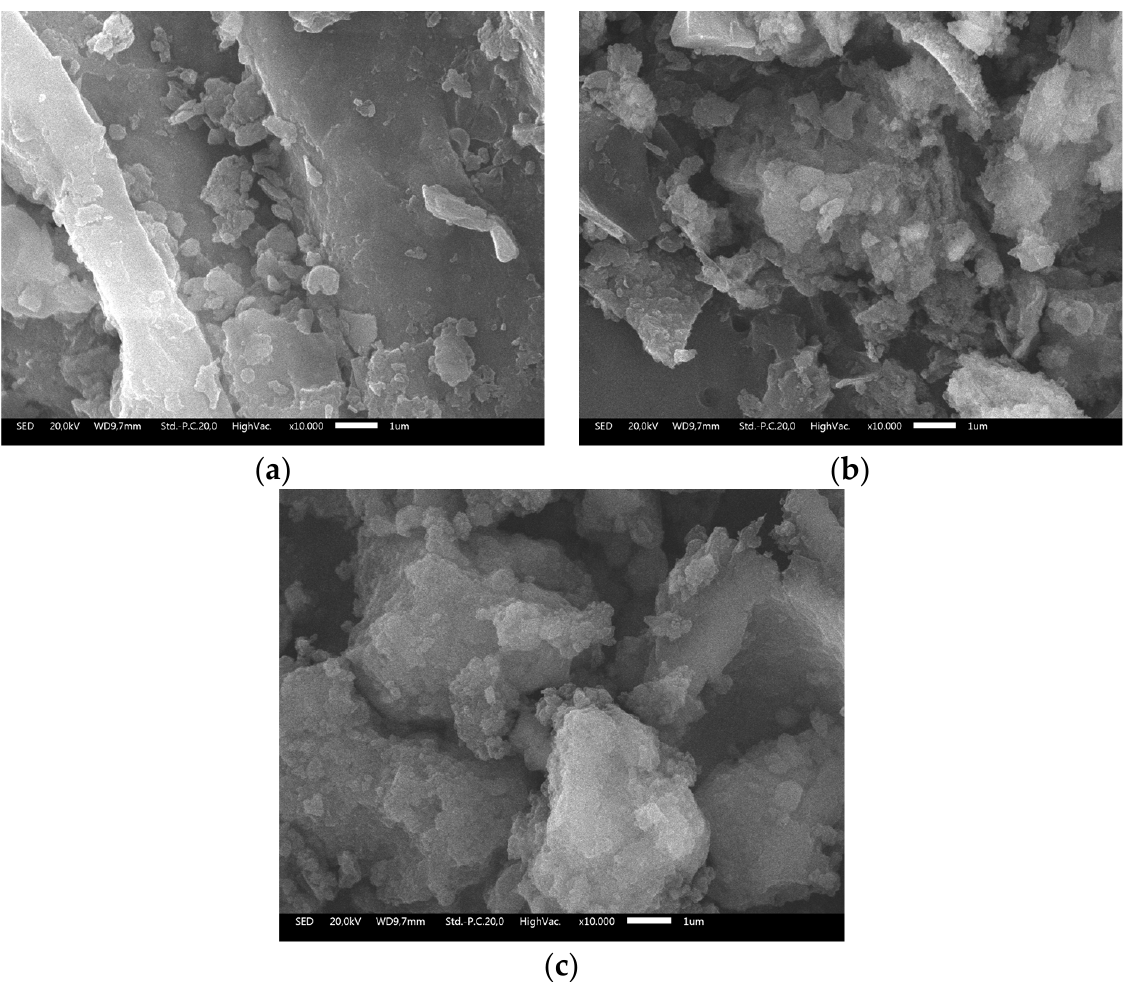
Figure 2. SEM-EDX analysis of compost ( a ), biochar ( b ) and humic acid ( c ) (10.000× magnification).